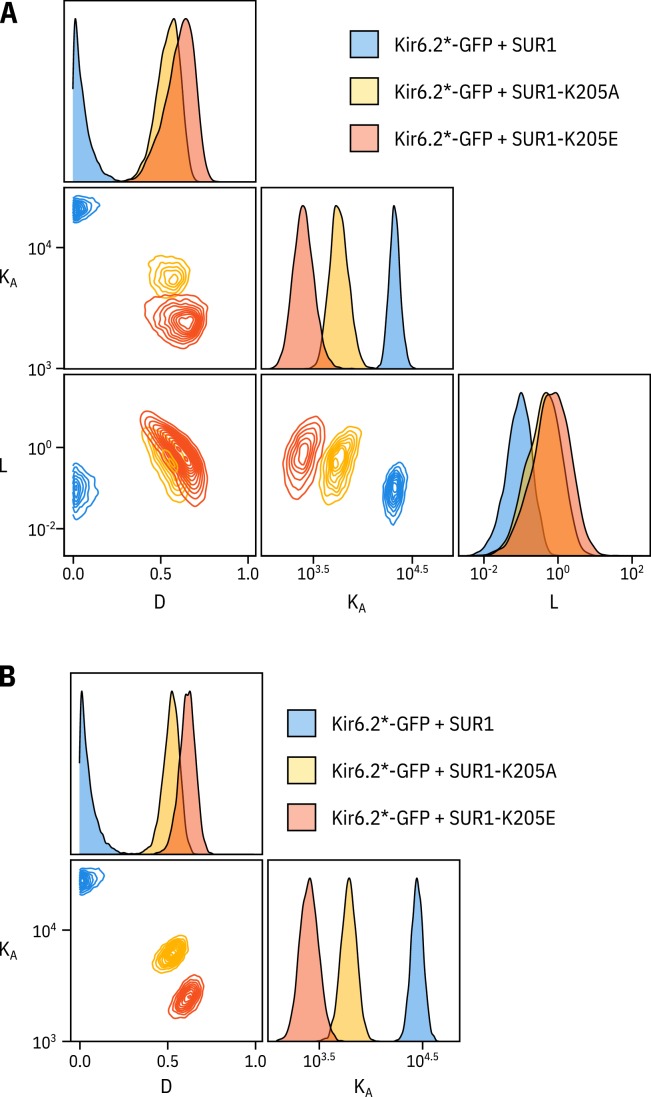
Fixing the L parameter does not drastically affect the fits to the SUR1-K205A or SUR1-K205E data.(A) Pairwise correlation plots of L, D and KA from the full MWC-type model fit to Kir6.2*-GFP co-expressed with wild-type SUR1, SUR1-K205A, and SUR1-K205E. (B) Pairwise correlation plots of D and KA from the full MWC-type as above with L fixed to 0.8 (Trapp et al., 1998).